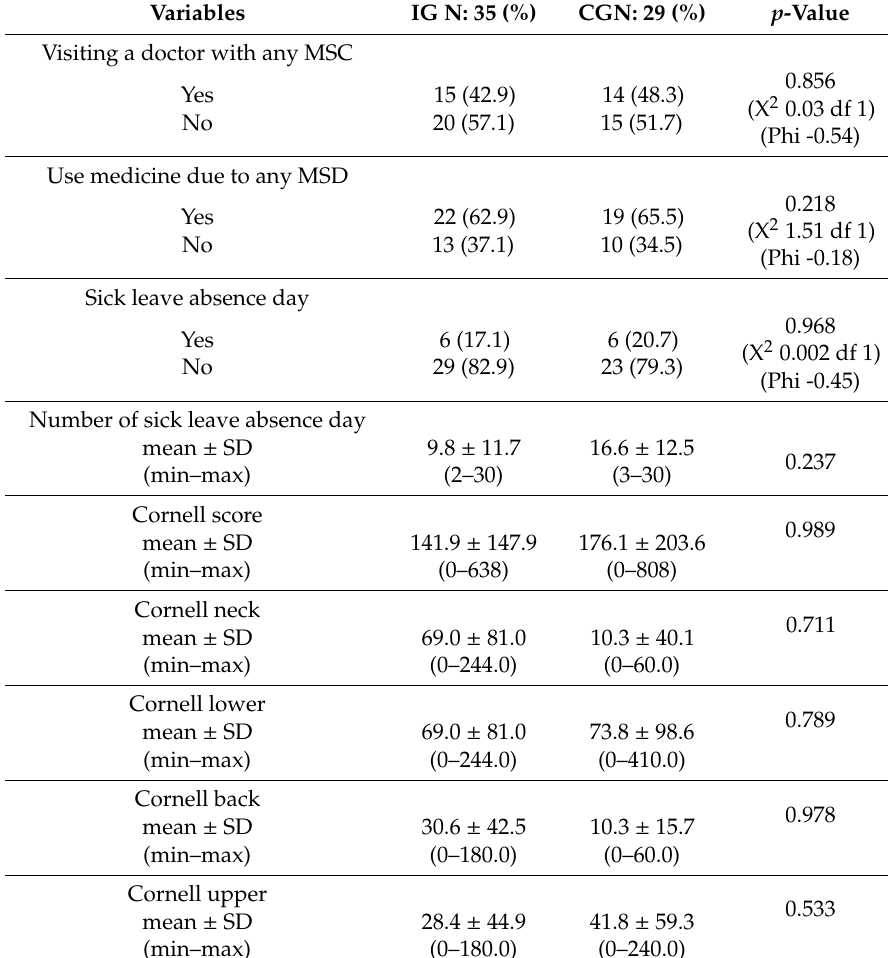
Table 2. Findings of musculoskeletal well-being parameters and C MSDQ scores in the last six months. Variables IG N: 35 (%) CGN: 29 (%) p